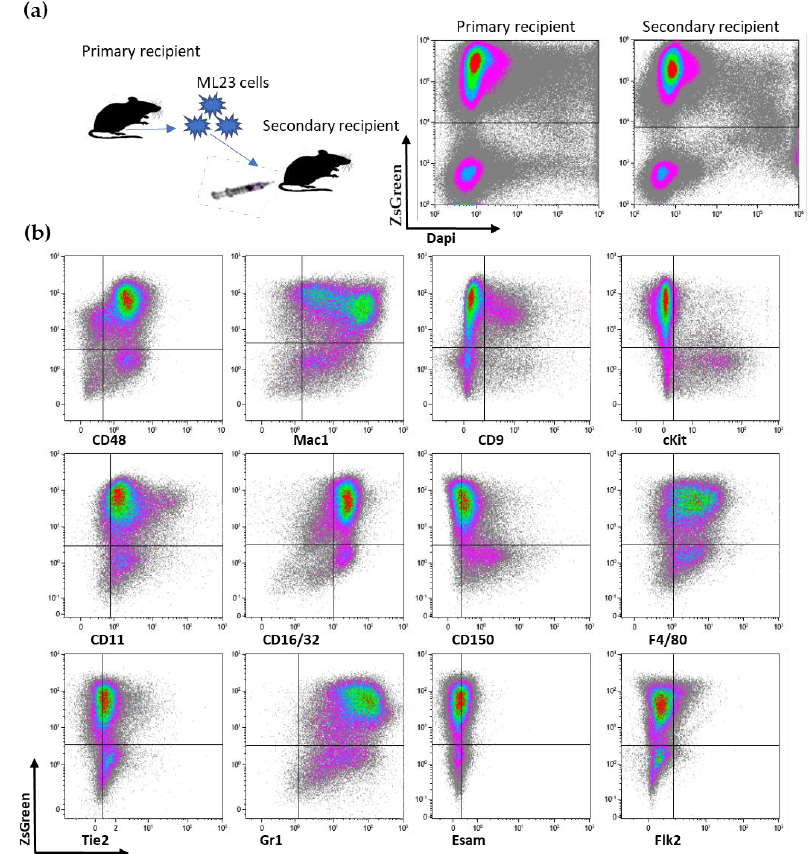
Figure 1. ML23 leukemia line passage serially with heterogeneous phenotype: ( a ) Mice were injected with leukemic ML23 cells from frozen stocks. After leukemia detection in PB, cells were harvested from the BM and injected into other recipients. FACS plot of the primary recipient is of one month after transplantation, and, for the secondary recipient, is from 2 to 3 wk after passage. ( b ) mFACS plots showing the expression of the indicated markers ( X axis), along with the ZsGreen reporter ( Y axis).